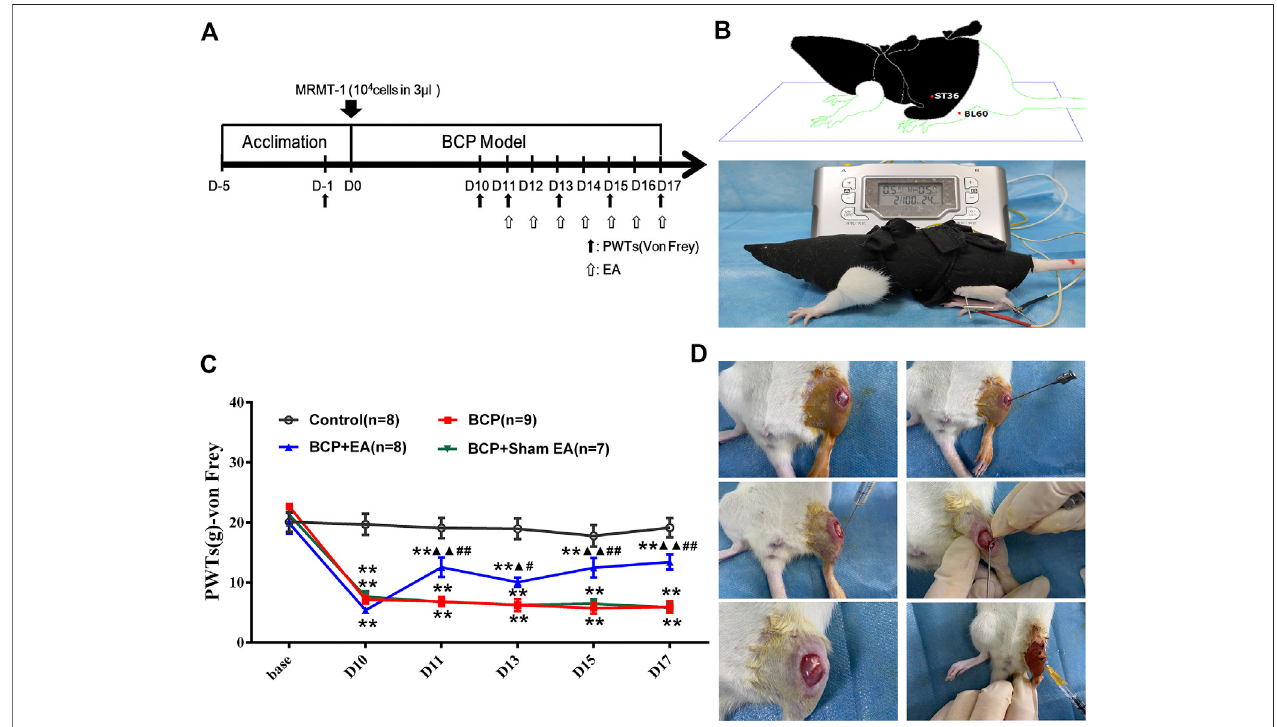
FIGURE1| EstablishmentoftheBCPratmodelandtime-coursechangeofPWTsinrats. (A) Timelineoftheanimalexperiment; (B) EAtreatmentonZusanli(ST36) and Kunlun (BL60); (C) time-coursechangeofPWTs. Compared with the control group, PWTs ofthe BCP, BCP+ EA, and BCP+ Sham EAgroups dropped drastically on postoperative day 10 and kept decreasing until day 17, indicating successful modeling. The PWTs of the BCP + EA group increased after intervention of EA on postoperative days11,13,15,and17. (D) Establishment oftheBCPmodel. PWTs:painwithdrawalthresholds;EA:electro-acupuncture;BCP:bone cancerpain; base:baseline.** p < 0.01,comparedwiththecontrolgroup; ▲ p < 0.05, ▲▲ p < 0.01,comparedwiththeBCPgroup;# p < 0.05,## p < 0.01,comparedwiththeBCP+ Sham EA